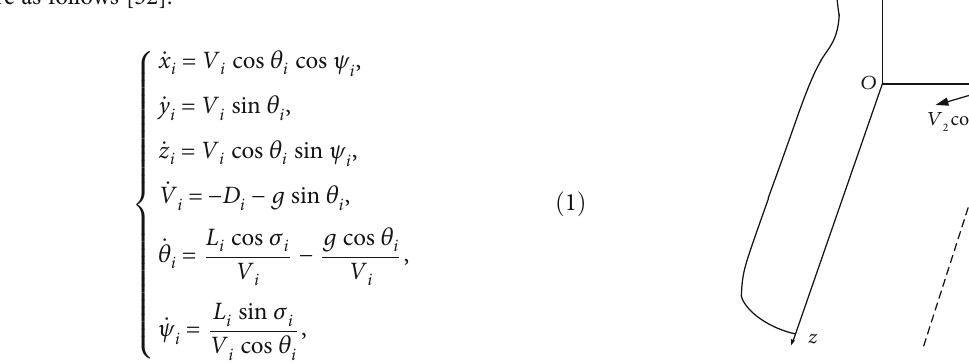
Figure 1: Formation coordinate